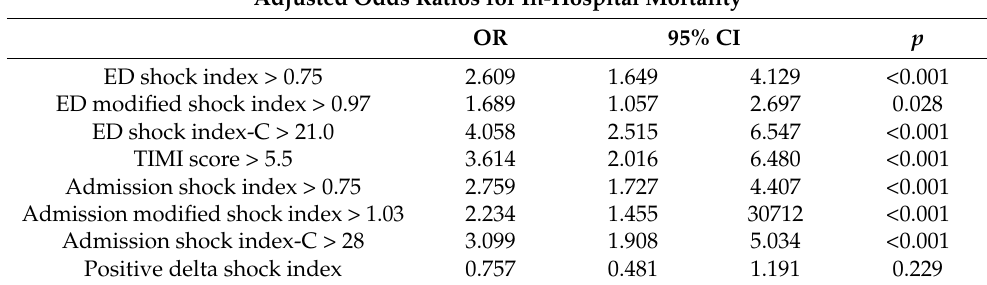
Table 4. Odds ratio (OR) and 95% confidence interval (95% CI) for in-hospital mortality in STEMI patients after adjusting for sex, age, diabetes, current smoking status, dyslipidemia, history of myocardial infarction, mechanical circulatory support, ECMO intervention, level of troponin I, fatal arrhythmia, and high Killip